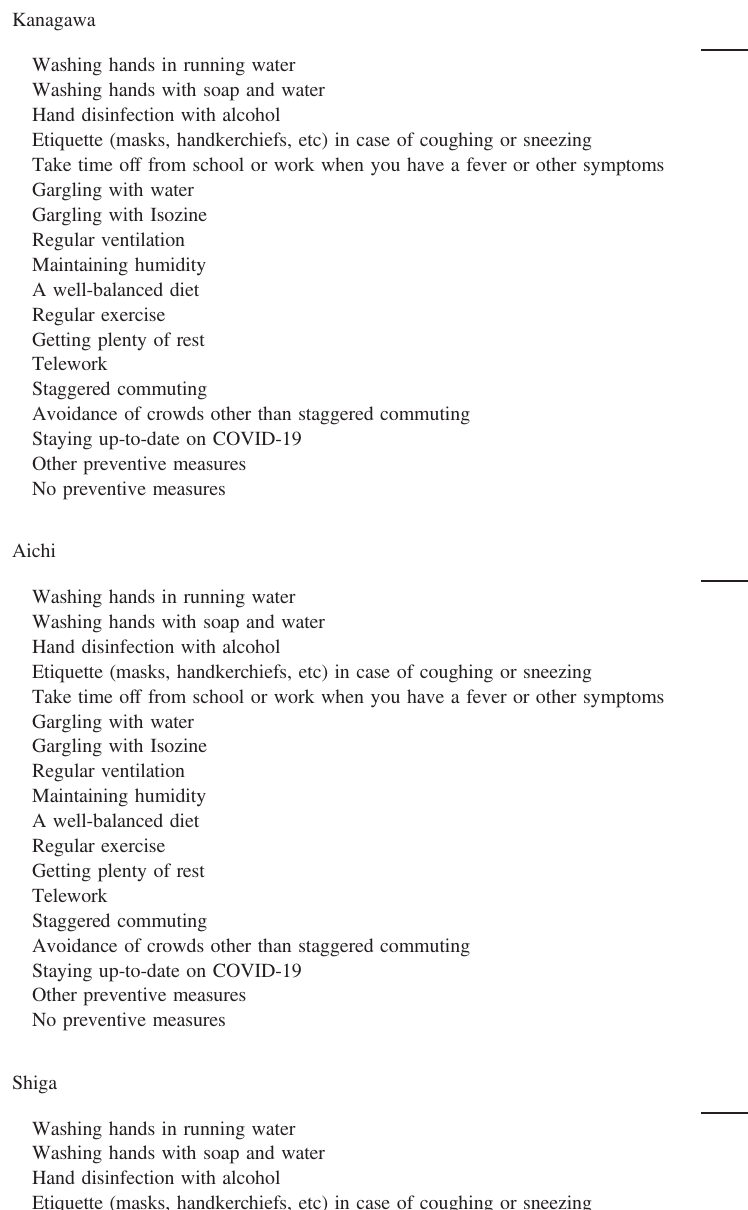
Mar 6 Mar 12 Mar 27 ( n = 23,944) ( n = 8,033) ( n = 23,625)